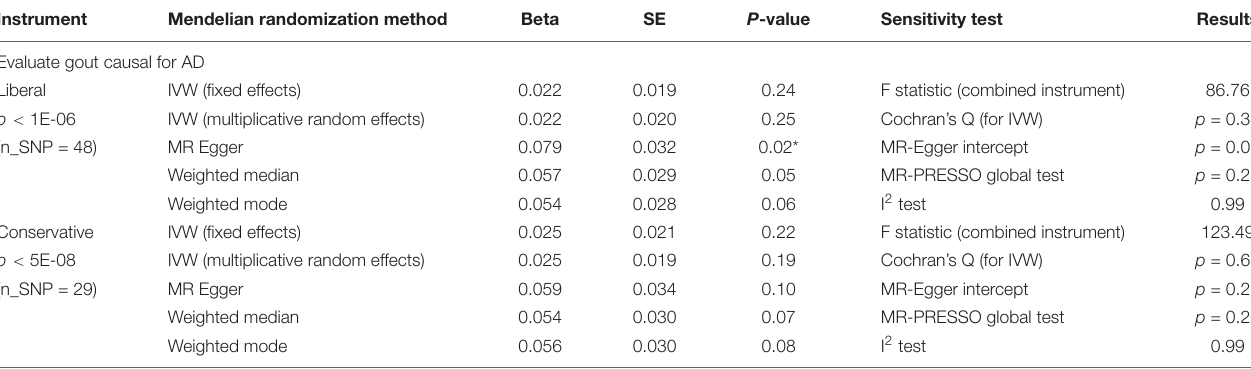
TABLE 5 | Two-sample Mendelian randomization to test causal relationship between gout status and Alzheimer’s disease. a